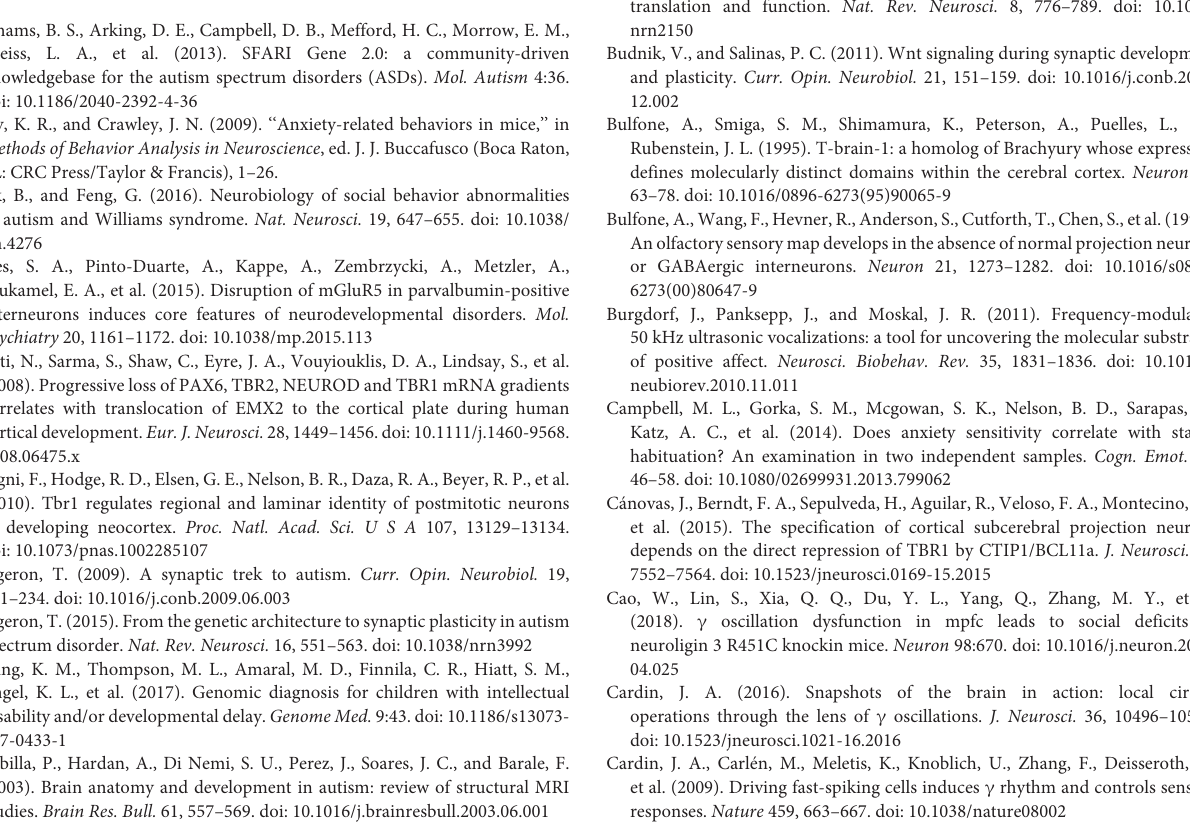
FIGURE S1 | qRT-PCR analyses for some of the DEGs from Tbr1 + / K228E and Tbr1 K 228E/K228E mice. (A) qRT-PCR analyses were performed for all five DEGs from Tbr1 + / K228E mice [(E16.5; LMBRD1, LYPD6, PDE3B, ILK, and CRX) and six DEGs (Tbr1 and six DEGs that are associated with ECM and extracellular GO terms indicated by underline ( Figures 3B,C )] from Tbr1 K 228E/K228E mice (E16.5). The genes that are increased and decreased in the expression in RNA-Seq analyses are indicated by red and blue colors, respectively. n = 5 mice (males and females mixed) for WT, Tbr1 + / K228E , and Tbr1 + / K228E , ∗ P < 0.05, ∗∗∗ P < 0.001, one-way ANOVA with Dunnett’s test. FIGURE S2 | Ctip2 marks layer 5 more strongly than layer 6. (A) Ctip2 marks layer 5 more strongly than layer 6 (lower two images) and, together with Tbr1, reveals the boundary between layers 5 and 6 (upper two images). The upper two images were borrowed from Figure 5A for comparison. TABLE S1 | All RNA-Seq data.